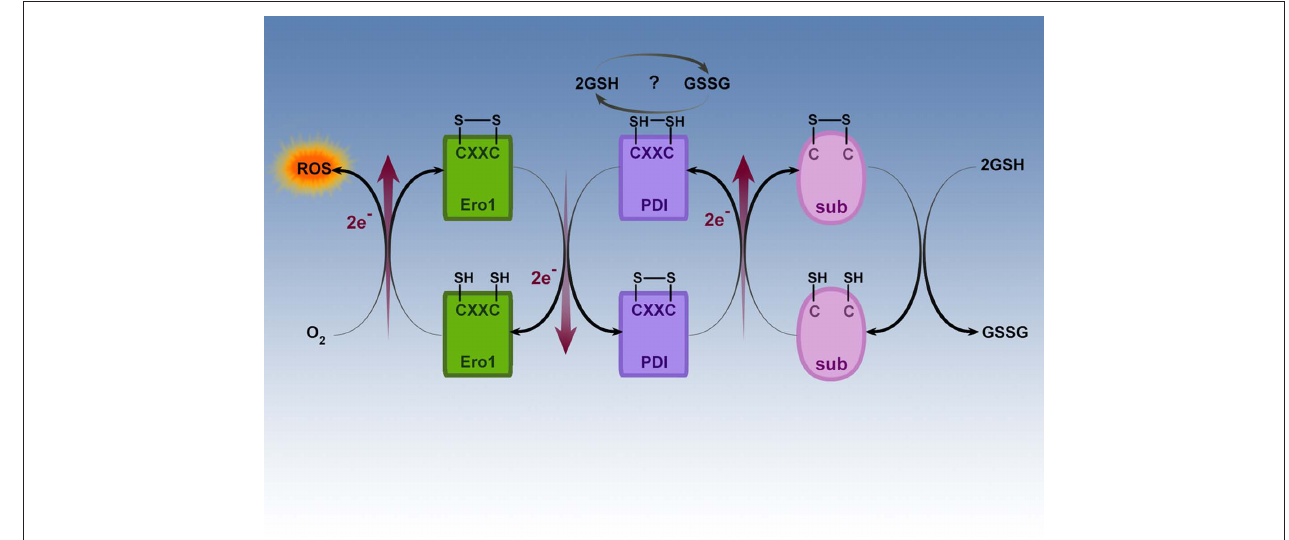
synthesized in the ER. Another product of these coupled reactions is ROS. Reduced glutathione is necessary to reduce incorrectly placed disulfide bonds so that the protein can be recycled for correct disulfide bridge formation and